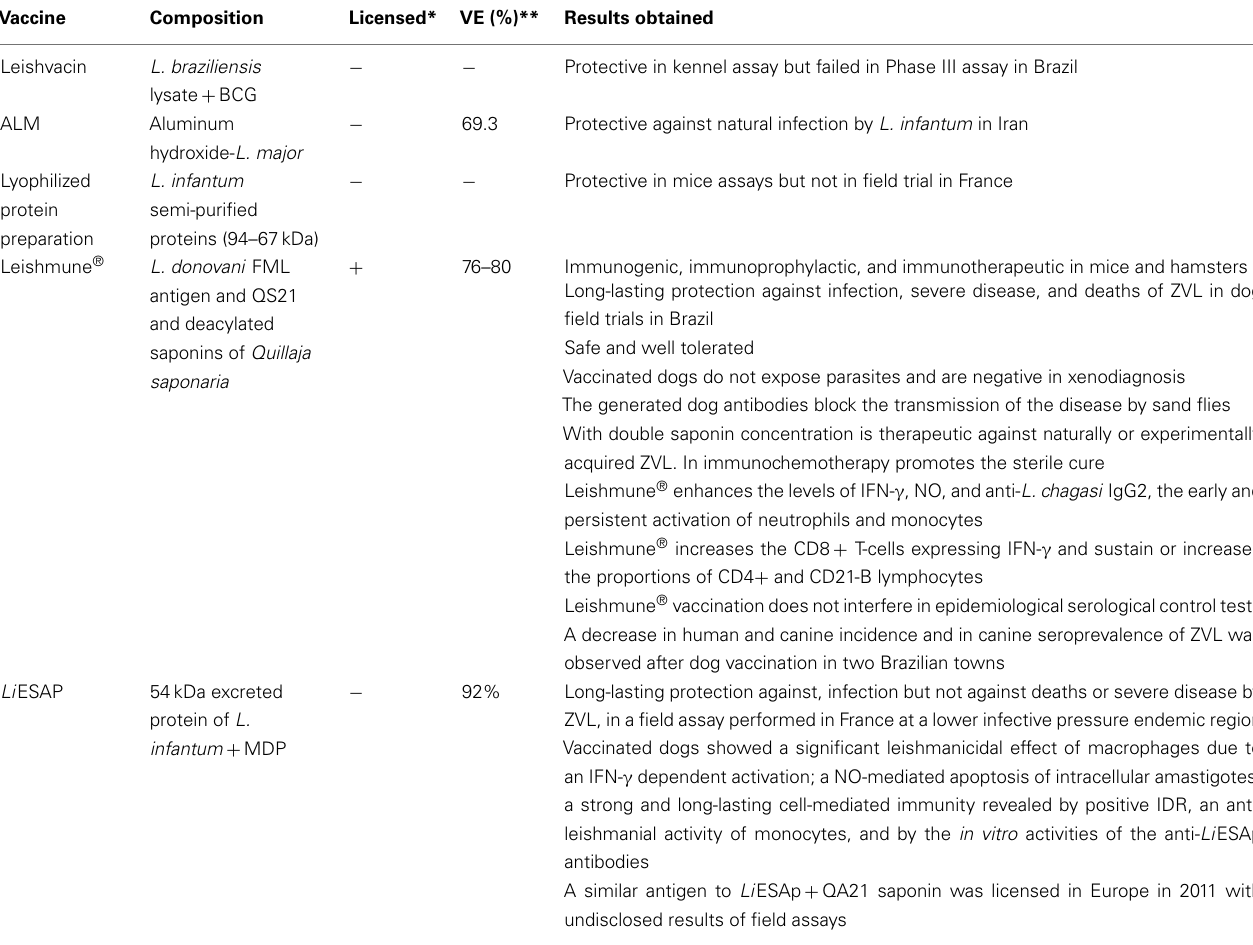
Table 1 | Canine vaccines for visceral leishmaniasis assayed in field trials.